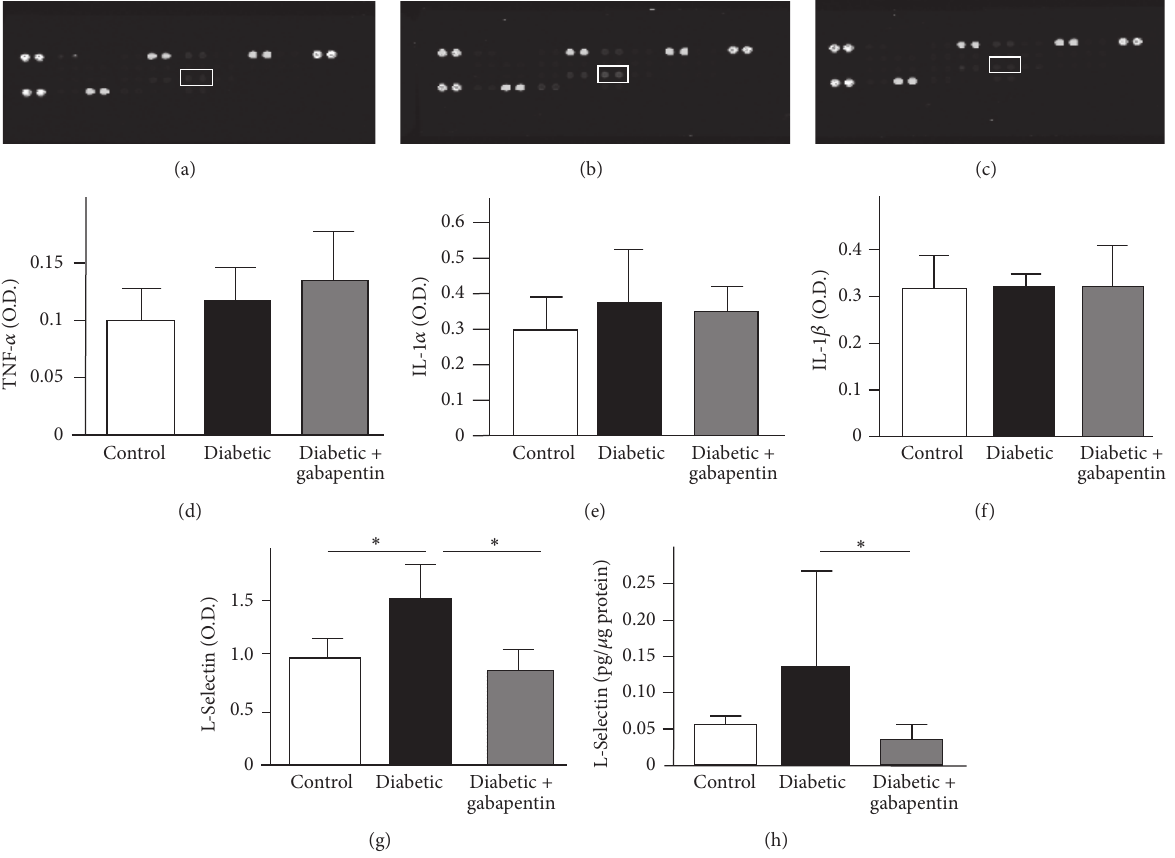
Figure 2: L-Selectin is increased in the spinal cord of diabetic rats. Cytokine proteome arrays were used to assay levels of 29 cytokines in (a) control,(b)untreateddiabetic,and(c)gabapentin-treateddiabeticrats.Therewasnochangeinthespinallevelsofclassicallyproinflammatory cytokines such as (d) TNF- 𝛼 , (e) IL-1 𝛼 , or (f) IL-1 𝛽 (g). However, L-selectin (highlighted in box in (a)–(c)) was significantly increased in diabeticratlumbarspinalcord,andthisincreasewasamelioratedbytreatmentwithgabapentin( ∗ 𝑝 < 0.05 ina1-wayANOVAwithBonferroni post hoc tests. Mean optical densities + SD are displayed; 𝑛 = 4 ). (h) This was independently confirmed with an ELISA; levels of L-selectin were reduced when diabetic rats were treated with gabapentin ( ∗ 𝑝 < 0.05 in a Kruskal-Wallis test with Dunn’s multiple comparison test; 𝑛 = 5